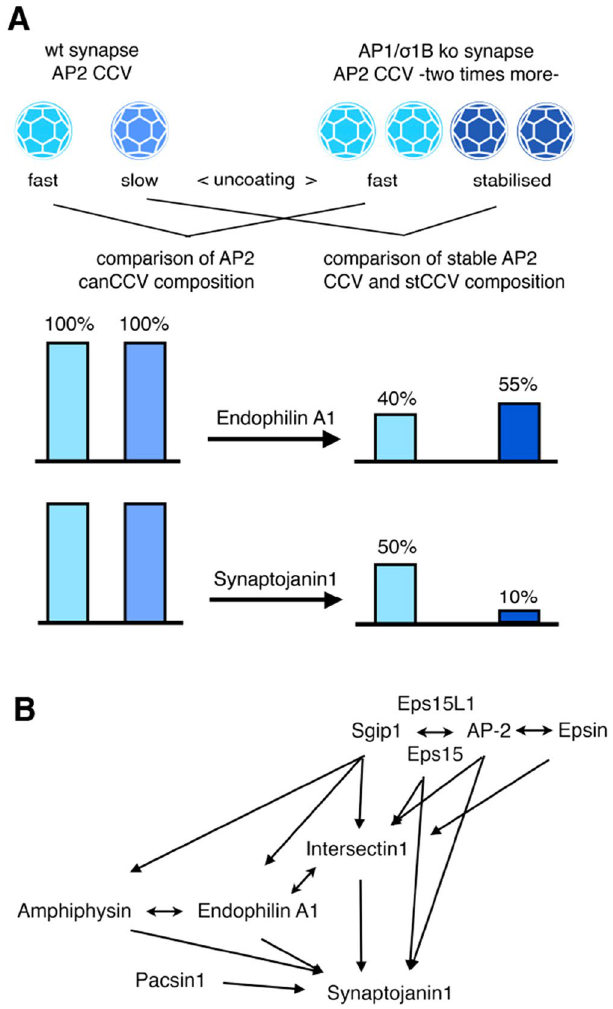
Figure 1. ( A ) Summary of alterations in the synaptic AP2 CCV pools, induced by impaired SV recycling due to AP1/σ1B-adaptin deficiency. Pool sizes of canonical canCCV and stable CCV are increased twofold and in addition, stable, slow uncoating CCV become more stabilised (stCCV) Bar diagrams indicate the protein reduction per CCV for endophilin and synaptojanin1. ( B ) The synaptojanin1 interactome of CCV proteins and their interactions. Clathrin and dynamin are not included. Proteins listed at the top appear first at a AP2 CCP. Both Eps15 proteins bind synaptojanin1. Pacsin1 belongs to the group of proteins recruited late during CCV